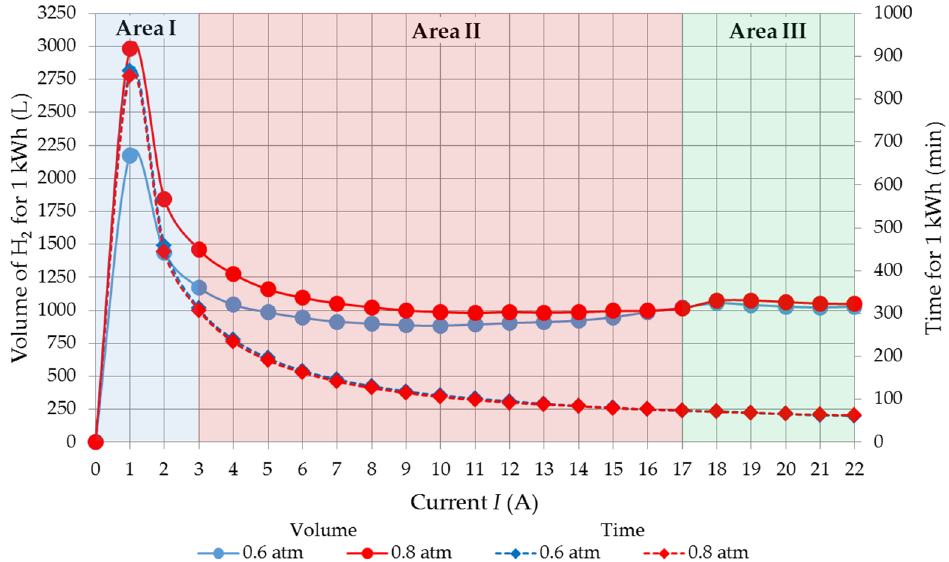
Figure 9. The volume of hydrogen (solid lines) and the time required to generate 1 kWh of electricity (dotted lines) at p = 0.6 atm (blue line) and 0.8 atm (red line). (dotted lines) at p = 0.6 atm (blue line) and 0.8 atm (red